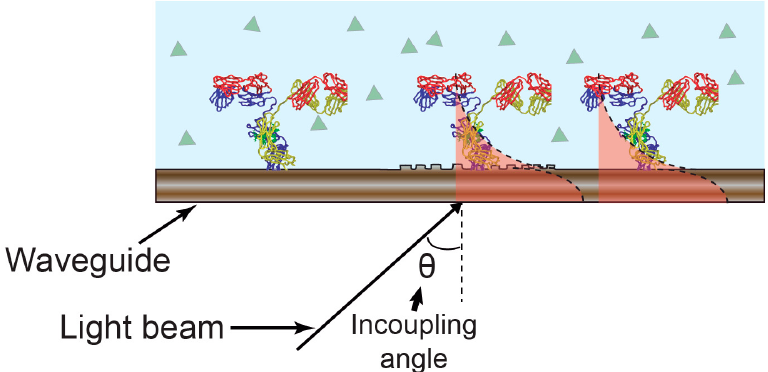
Figure 4. Optical waveguide lightmode spectroscopy (OWLS) sensing mechanism. The incoupling angle varies as a function of the refractive index as experienced by the guided optical mode.